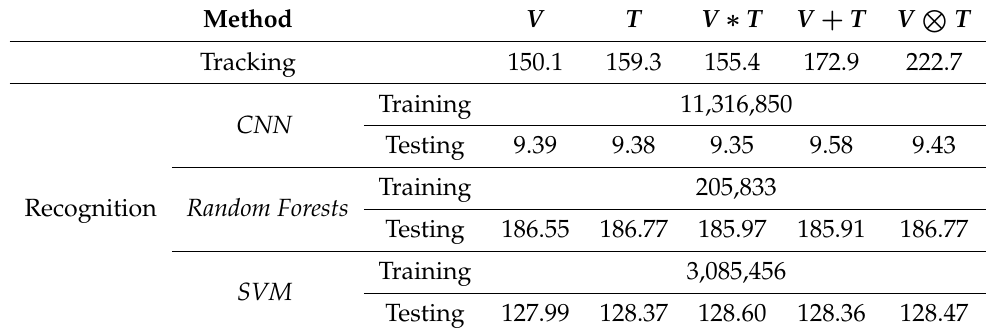
Table 2. The average processing times for CNN, Random Forests, and SVM. Training and testing for recognition with CNN are performed with parallel processing by four-core CPU, and time per frame is measured for tracking. Unit: milliseconds.